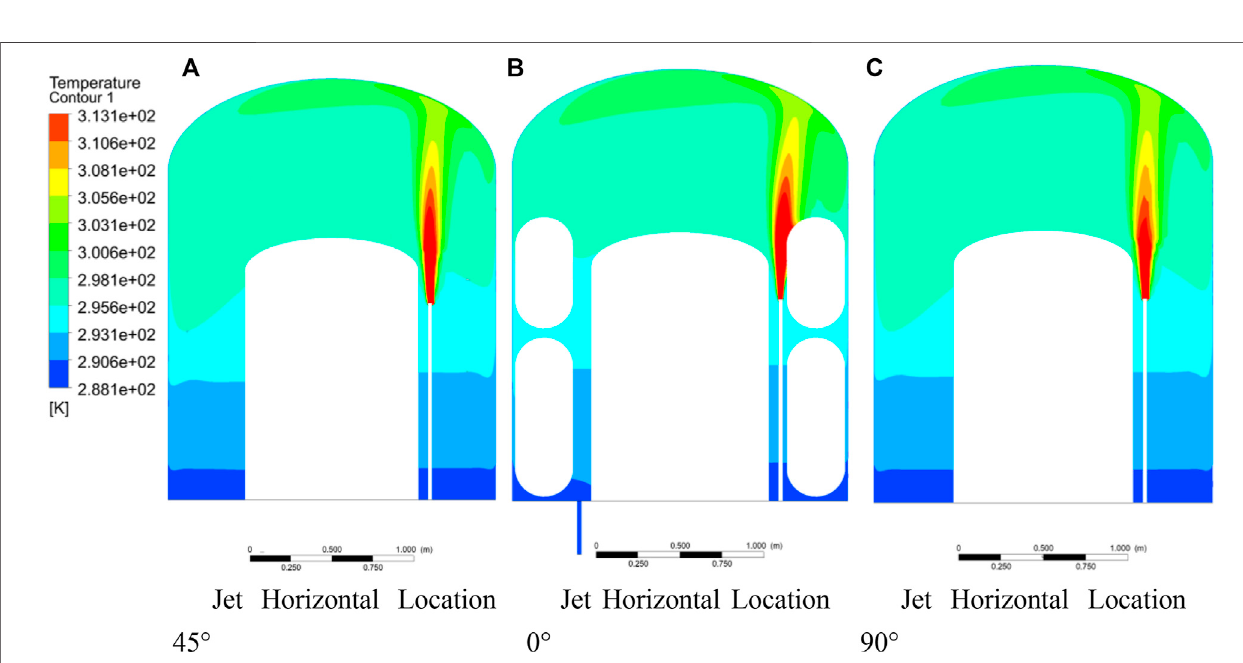
Frontiers in Energy Research |